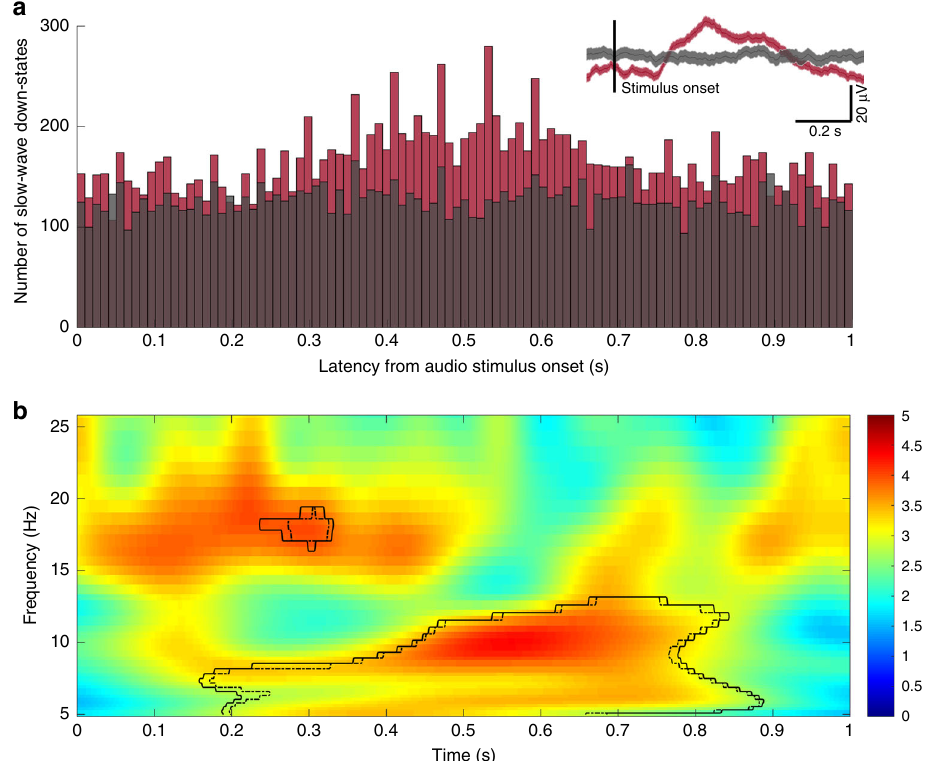
Fig. 6 Slow-wave entrainment to 1 Hz acoustic stimulation. a Number of detected slow-wave oscillations relative to stimulus onset, summed over the 99 electrodes analyzed, in a 5-min interval for subject A4 during stimulation (red) and an equivalent baseline sleep period (black). Inset shows the averaged evoked response in both conditions in one representative electrode (depth electrode DPMT 03), time-locked to stimulus onset (note the positive peak a cortical down-state in this depth electrode, which is opposite from the majority of cortical electrodes shown as examples in Fig. 3b). b TFR of time-locked epochs (e.g., relative to stimulus onset) in one representative electrode (DPMT 03), showing an increase in slow spindle power (8 – 12 Hz) during slow- wave “ down-states ” consistent with previous literature 80 (0.4 – 0.8 s RE: stimulation onset) and fast spindle power (12 – 18 Hz) during “ up-states ” (0.15 – 0.4 s, RE: stimulation onset) as found for endogenous slow-wave oscillations (see Figs. 3, 4). TFR is computed relative to baseline sleep period with sham stimulation. Solid innermost curve represents signi fi cant increases relative to baseline after FDR correction (one-tailed t -test, p <